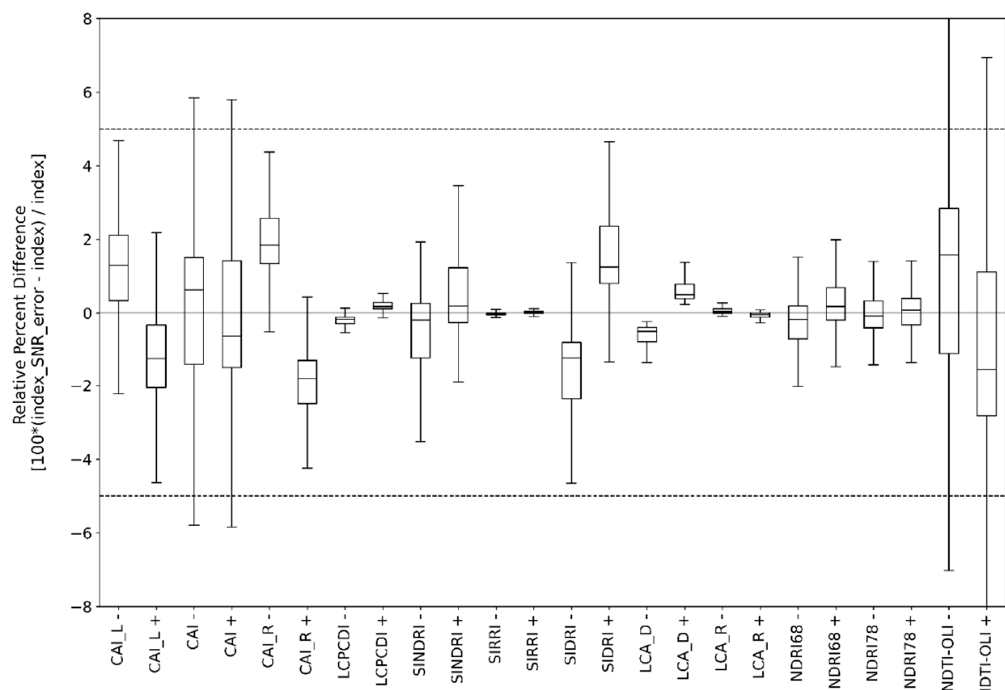
Figure 8. The impact of SNR NED ρ uncertainty on the generation of NPV indices, using bandwidths described in Figure 7. Note that the indices exhibit differences in +/- absolute error. The higher RPD values of NDTI are likely attributable to OLI band 6 NED ρ values being substantially lower than values for SWIR bands > 2000 nm that drive an equivalent OLI Band 7, resulting in greater relative differences.